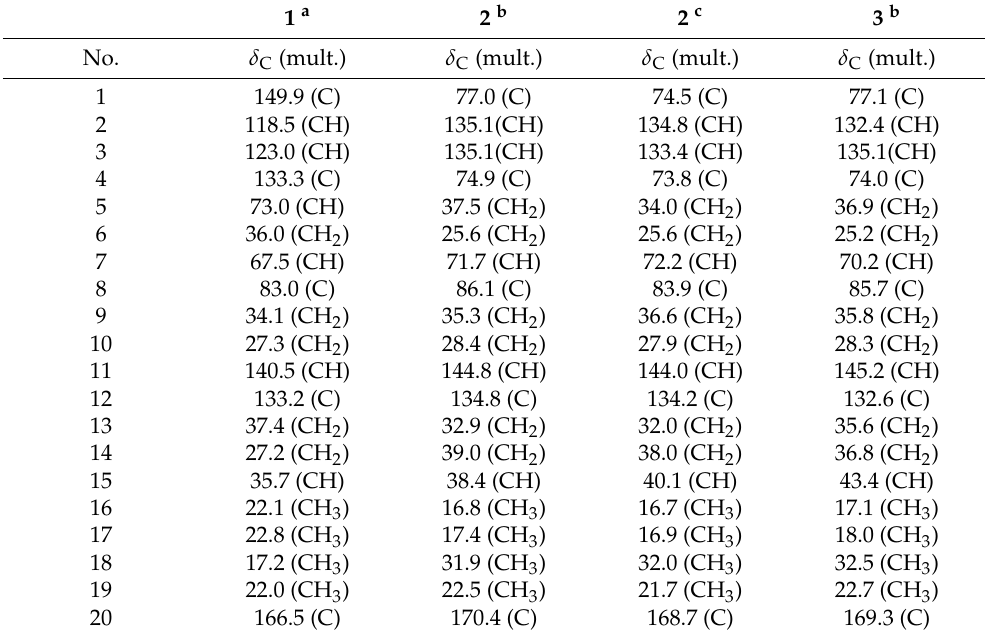
Table 2. 13 C NMR spectroscopic data of compounds 1 – 3 .